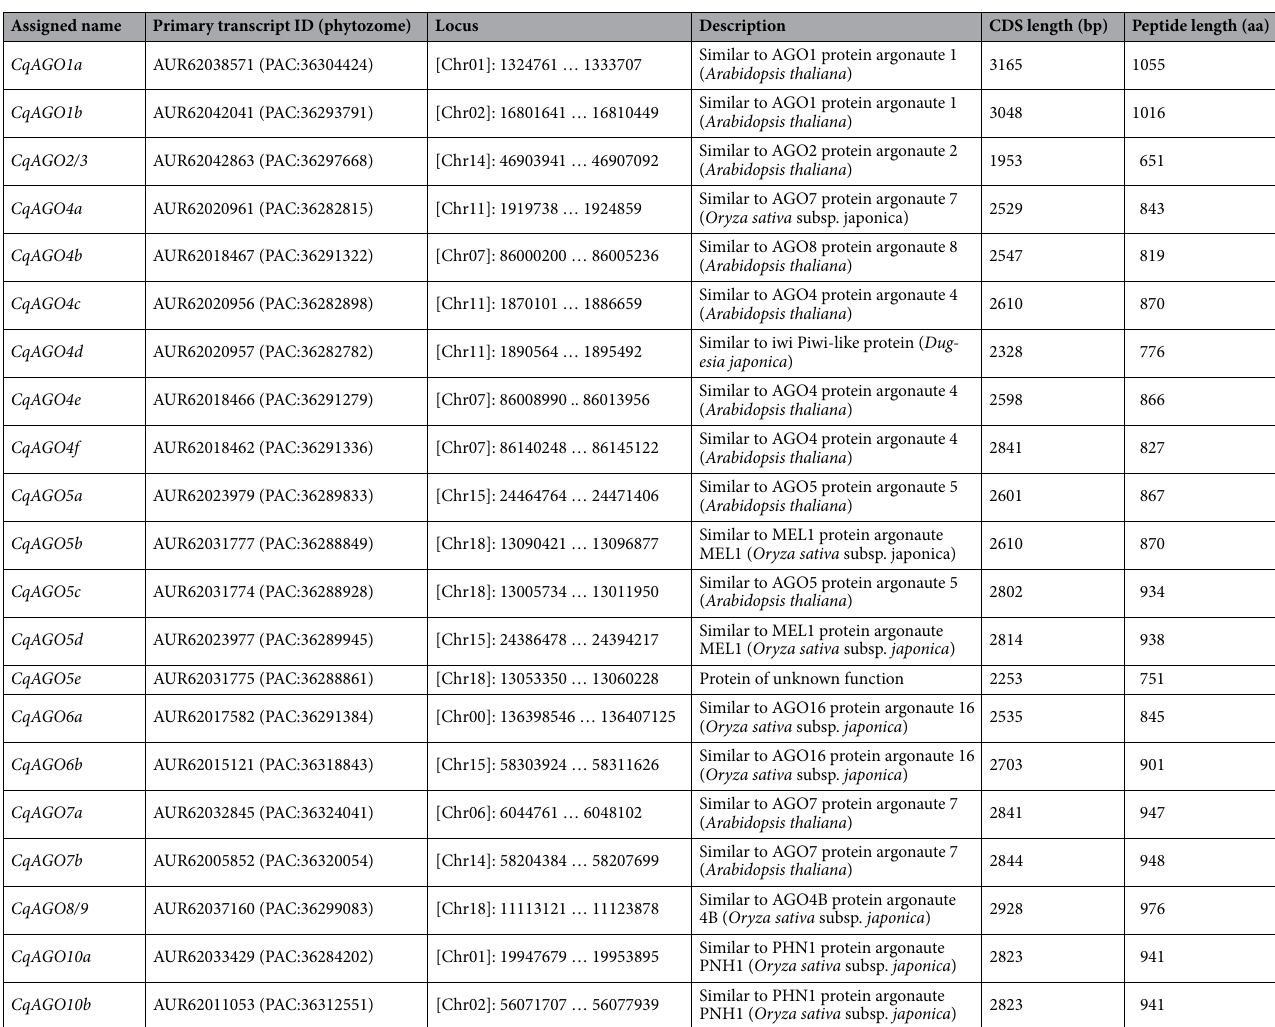
Table 1. Information about the predicted CqAGO gene